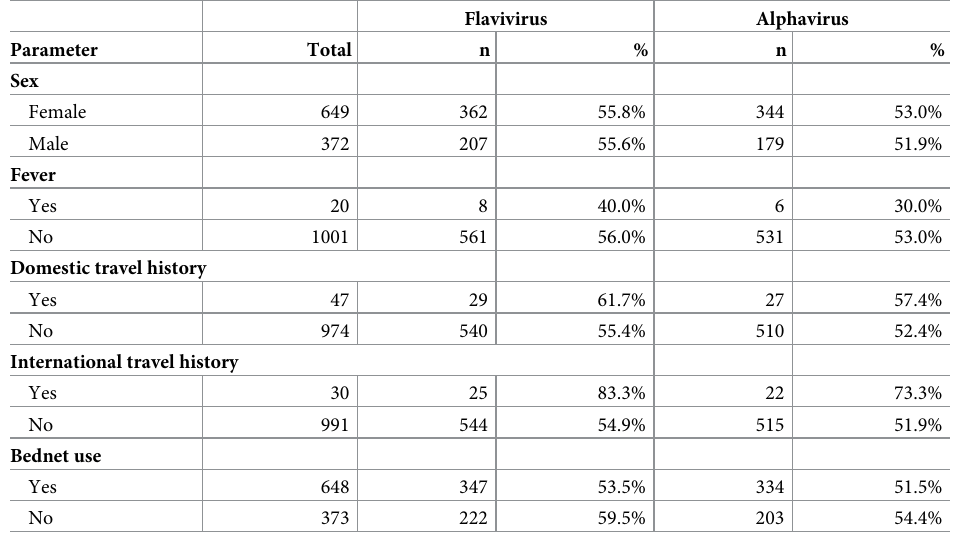
Table 3. The number and percentage of participants that were positive flaviviruses or alphaviruses summarised by the various explanatory